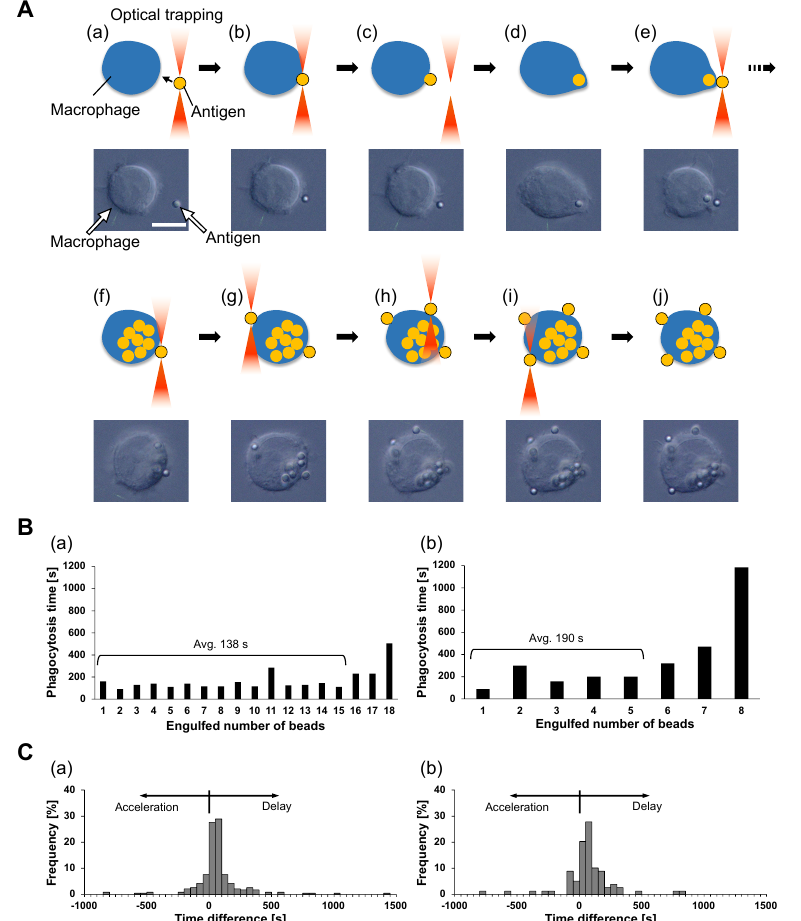
Figure 3. Evaluation of phagocytic antigen number dependence of phagocytosis time after feed- ing with optical tweezers. ( A ). Schematic drawing and micrographs of one-by-one phagocytosis process. ( a ) Transport of first antigen IgG/BSA-PS bead with optical tweezers. ( b ) Contact of first antigen bead with cell. ( c ) Removal of optical trapping after antigen bead adhesion. ( d ) Completion of phagocytosis for first bead. ( e ) Contact of second antigen bead. ( f ) Contact of antigen bead after the macrophage reached its maximum limit of phagocytosis. ( g – i ) Contact of additional beads on the other areas of the cell. ( j ) Final state. Bar: 10µm. ( B ). Typical example of phagocytosis number dependence of phagocytosis time in 2µm ( a ) and 4.5µm ( b ) IgG/BSA-PS bead phagocytosis, respec- tively. ( C ). Histogram of difference in phagocytosis time in adjacent phagocytosis in 2µm (( a ), n = 235 phagocytosis) and 4.5µm (( b ), n = 79) IgG/BSA-PS bead phagocytosis,